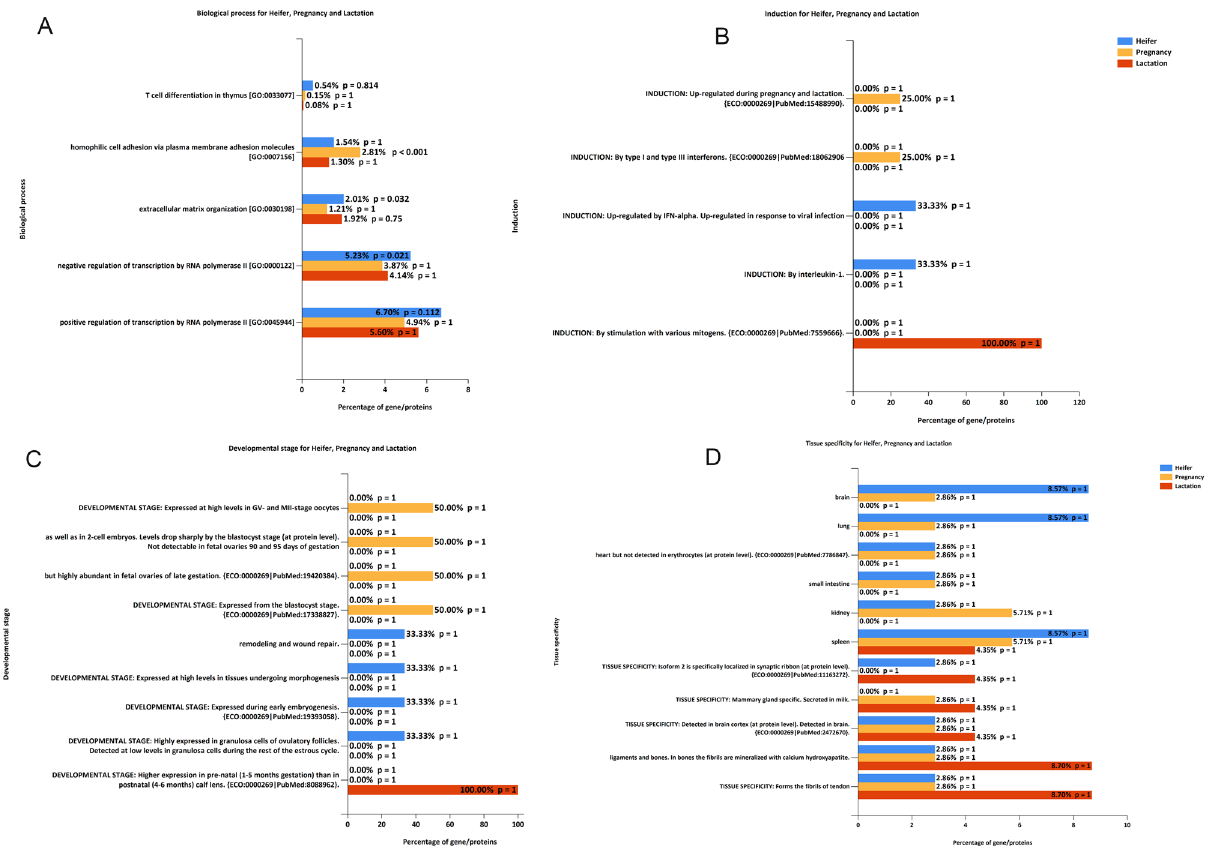
Figure 7. ( A ) Biological process analyses ( B ) Induction of proteins respective to specific conditions. ( C ) Developmental proteins analysis in all three conditions. ( D ) Tissue-specific proteins analysis in three physiological